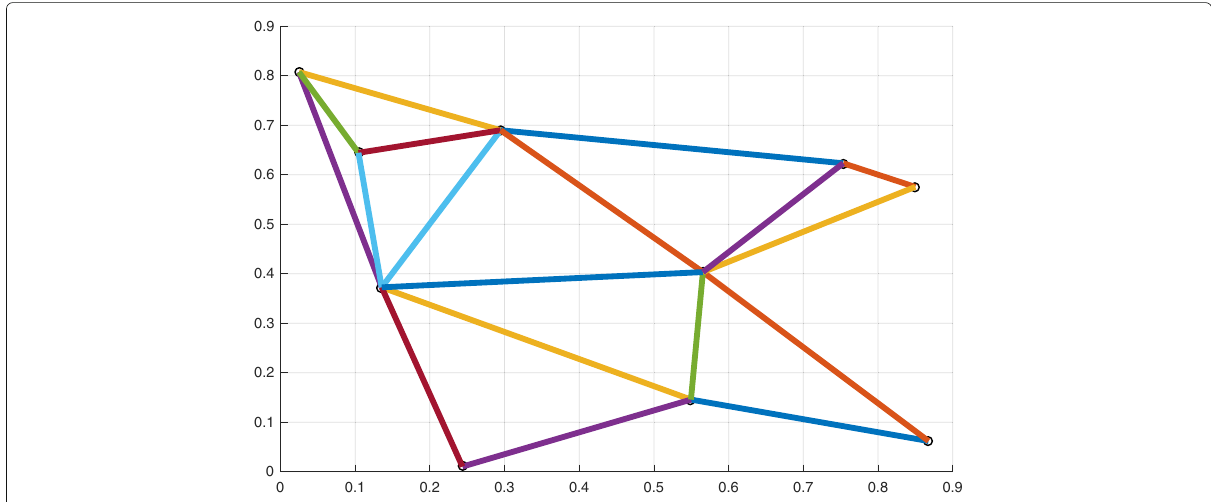
Fig. 1 Network deployment of 10